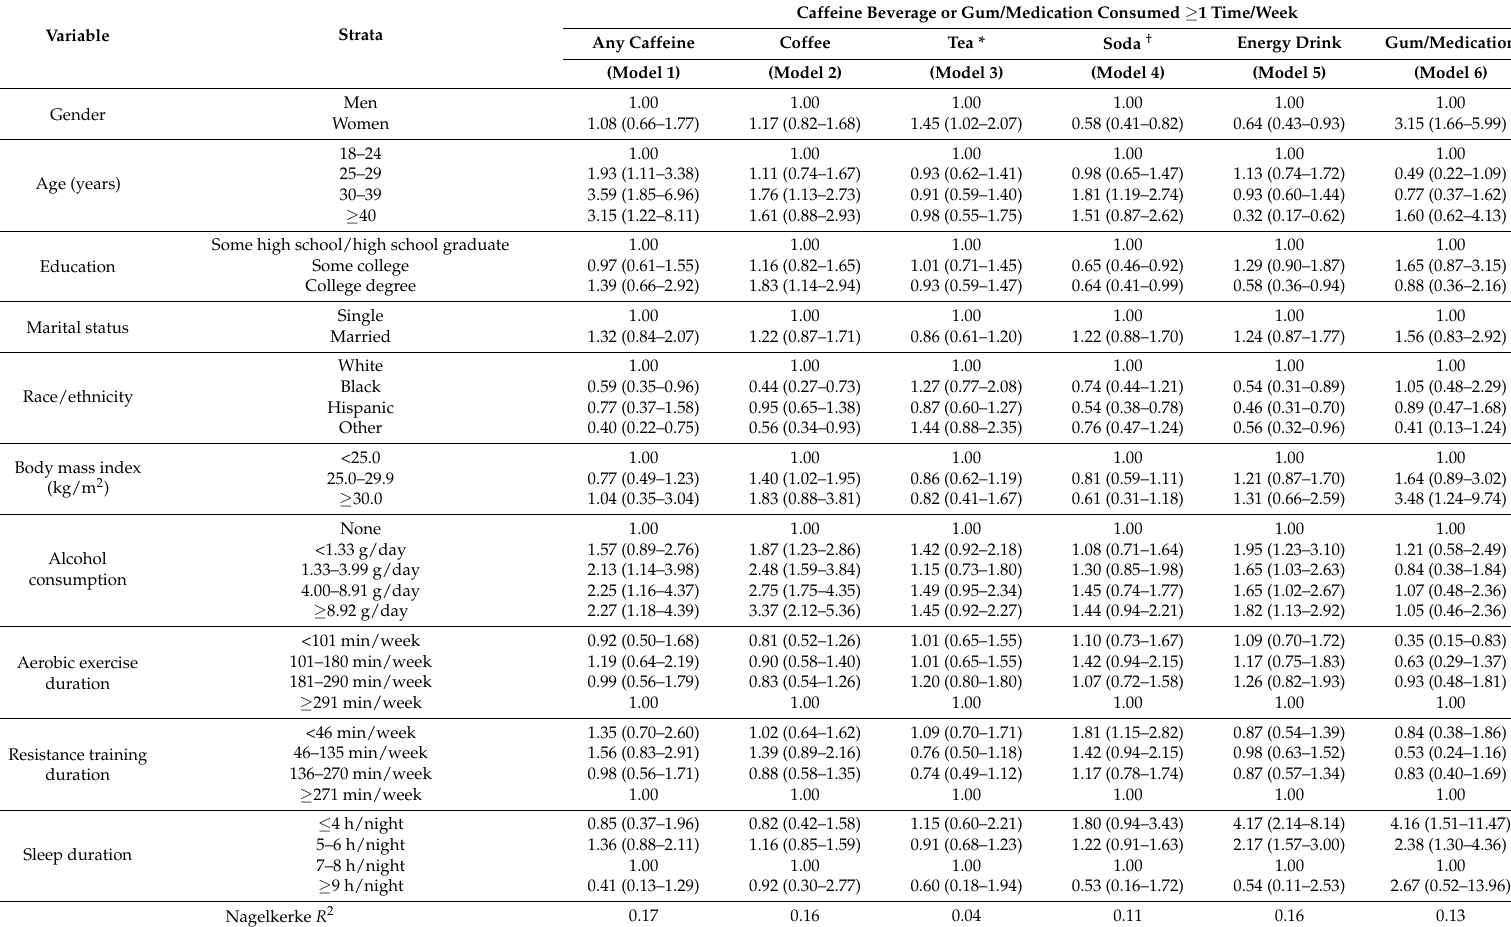
Table 8. Characteristics associated with use ( ≥ 1 time/week) of specific caffeine products among Marine Corps personnel. Multivariable logistic regression was used. Data are presented as odds ratios adjusted for other factors listed with 95% confidence intervals. The odds ratio 1.00 represents the reference group for each